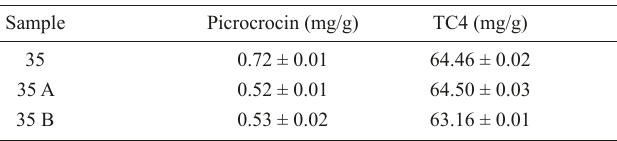
Fig. 7: 1 H NMR (DMSO-d6, 600 MHz) profile of sample 35 and after two years kept in the dark (35A) and in the light (35B). Tab. 4: Concentration of picrocrocin and TC4 of saffron powder before the storage (sample code 35) and stored one year in the dark (35A) and in the light